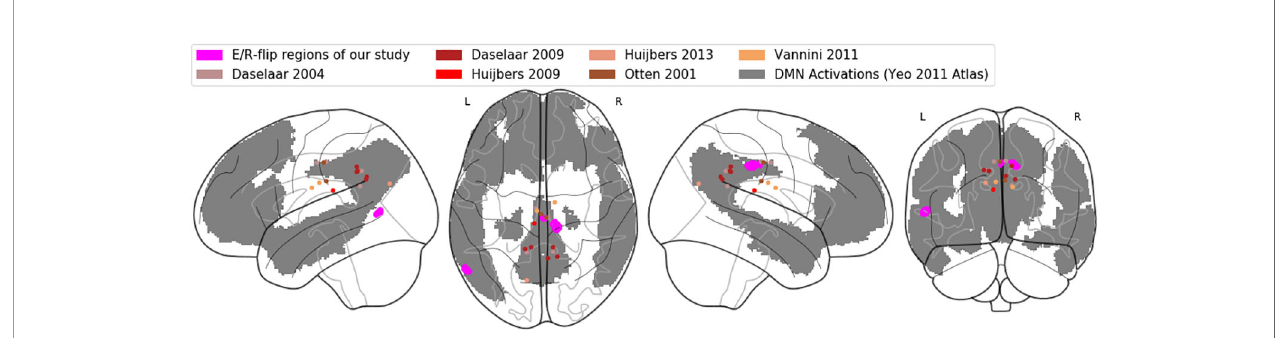
FIGURE A-1 | Comparative visualization of pMCC activation: Glass brain rendering of the pMCC activation of the conjunction analysis (magenta), together with (de-) activations labelled as PMR in previous studies (brown/red dots). The grey shaded areas represent the default-mode network in the atlas of Yeo